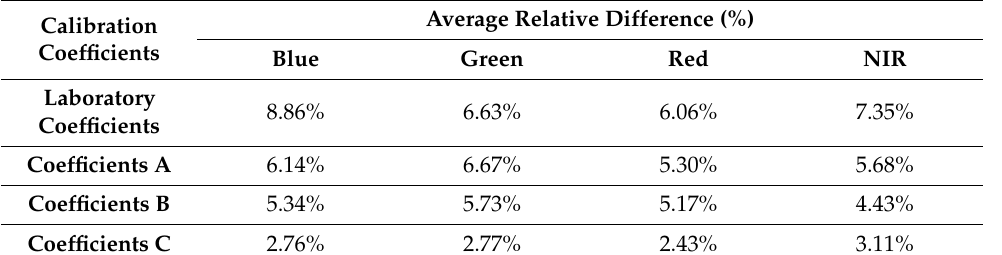
Table 9. Comparison of results between ZY3-02 MUX Measured TOA Radiance using different calibration coefficients and Landsat-8 OLI TOA Radiance after SBAF correction.